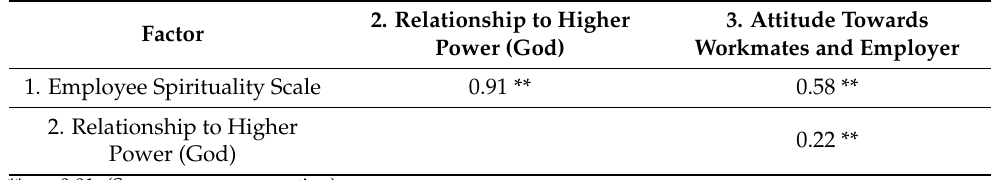
Table 3. Correlations between employee spirituality scale and its dimensions ( N = 460).